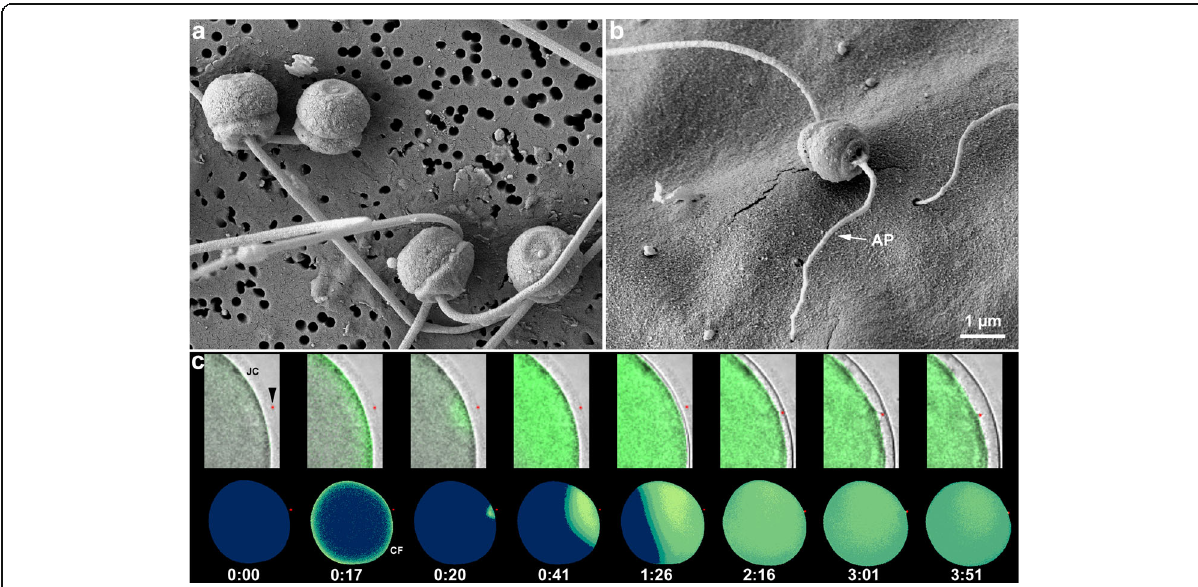
Fig. 4 Acrosome reaction in P. pectinifera spermatozoa and the sperm-induced Ca 2+ responses in the egg. a Scanning electron microscopy micrographs of spermatozoa fixed in natural seawater without eggs. No sign of acrosome reaction is present. b P. pectinifera spermatozoa on the egg surface after acrosome reaction has taken place (see the long filamentous process, AP). c Ca 2+ signals in a mature egg of Astropecten aranciacus following the interaction of the tip of the AP with the egg surface. A simultaneous increase of Ca 2+ over the entire periphery of the egg (cortical flash, CF) is observed when the fertilizing sperm head (marked in red dot) is still in the outer jelly coat (JC) (t = 0:17). This Ca 2+ increase is followed by a Ca 2+ wave that starts from the sperm-egg interaction and propagates to the opposite side of the egg, while the head of the sperm is still far away from the egg surface (t = 0:20). Only after the Ca 2+ wave has spread globally to the opposite side do sperm become incorporated into the egg by passing through the